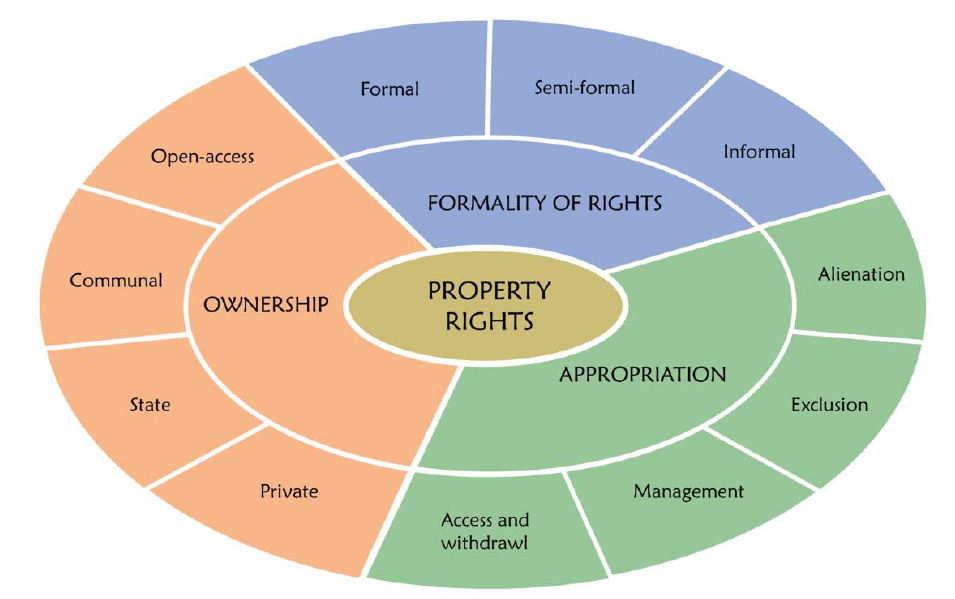
Figure 2. Conceptual framework of property rights in land development. Source: modified from